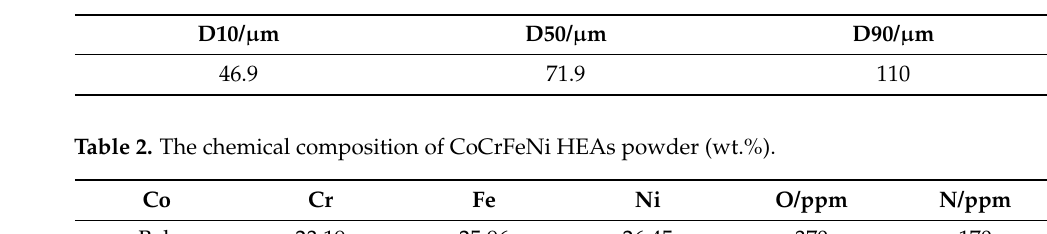
Table 1. Particle size distribution of CoCrFeNi HEA powder.